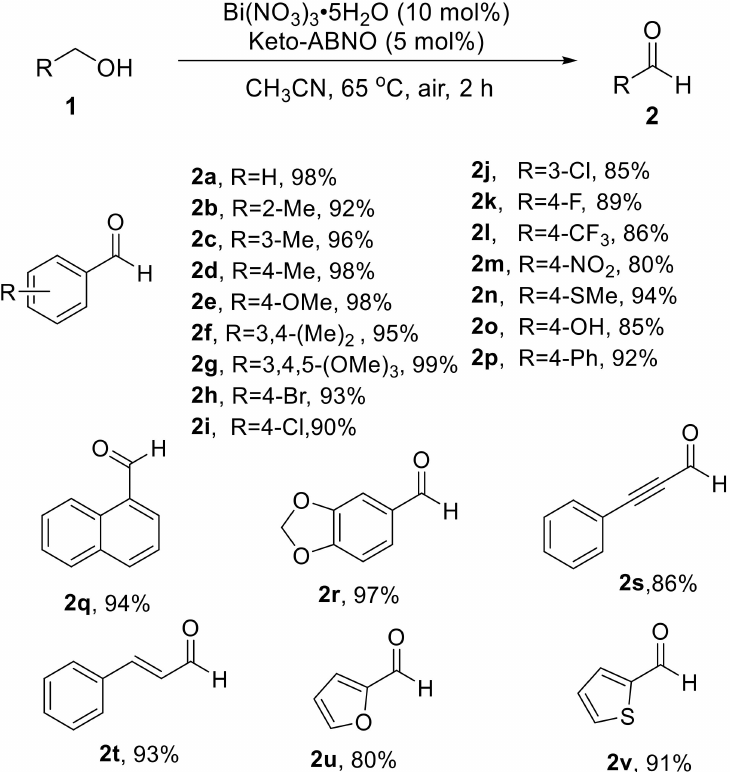
Scheme 2. Aerobic oxidation of primary alcohols to aldehydes. Reaction condition: 1a (1